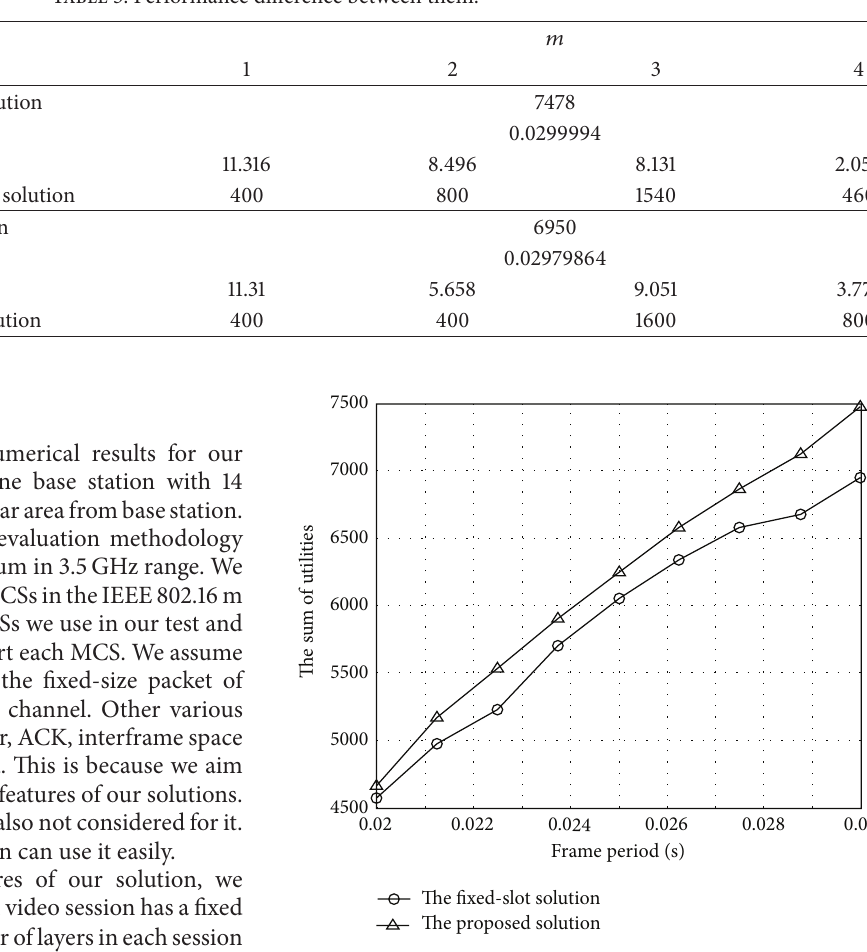
Table 3: Performance difference between them.